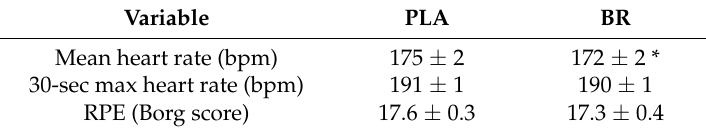
Table 1. Heart rate data and Rate of perceived